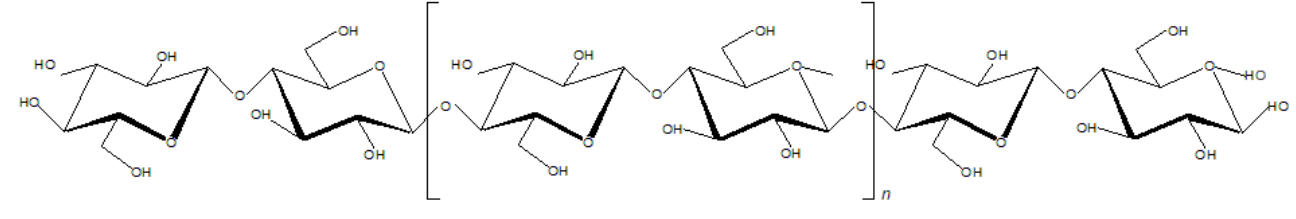
Figure 1. Structure of cellulose.